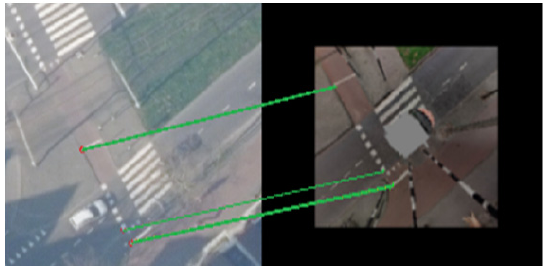
Figure 14 Förstner Cross-Correlation matching result of 9 th tile